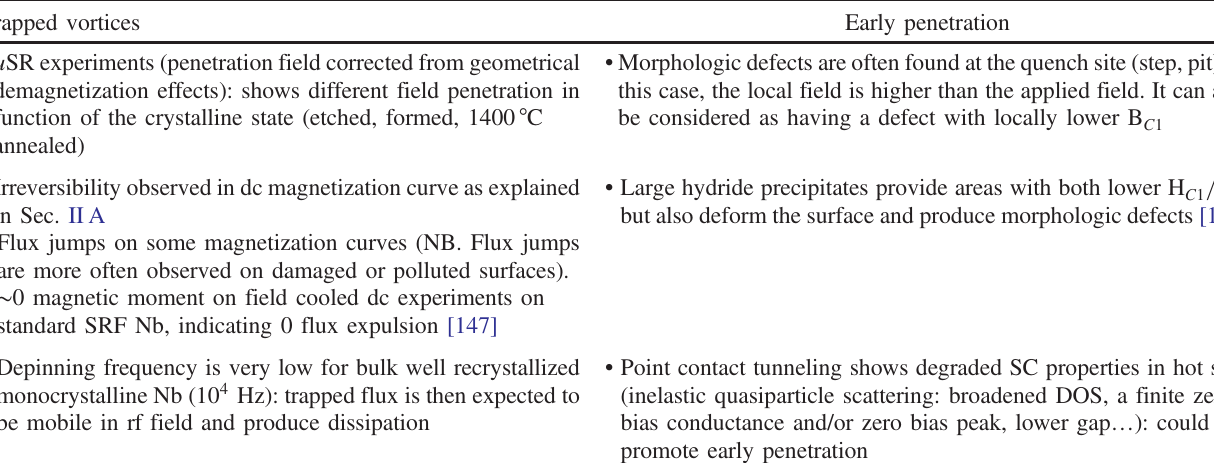
TABLE I. Trapped vortices vs early penetration: Experimental arguments [25,31,32,83,140,144 – 146]. Trapped vortices Early penetration (cid:129) μ SR experiments (penetration field corrected from geometrical demagnetization effects): shows different field penetration in function of the crystalline state (etched, formed, 1400 °C